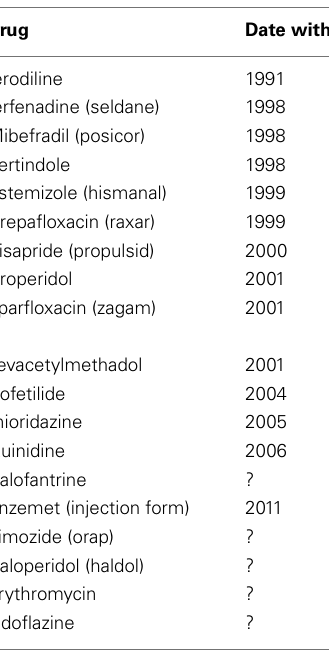
Table 4 | Drugs withdrawn due to